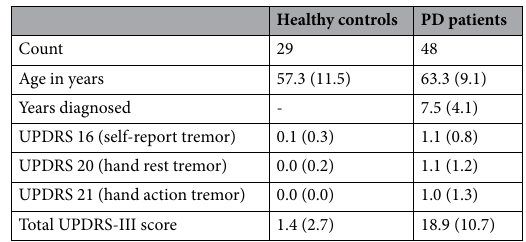
Table 5. Clinically-assessed subjects that contributed acceleration data. All values (except count) refer to the population mean, with the standard deviation given inside